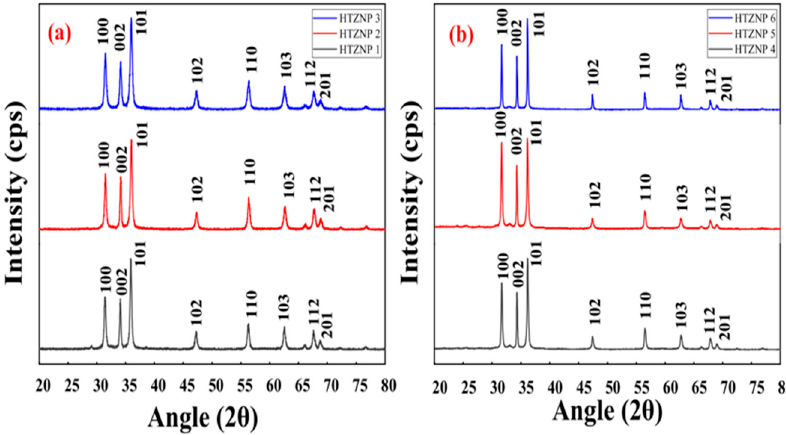
Figure 3. XRD patterns of sample synthesis with constant reaction time and different temperatures ( a ) (HTZNP1, HTZNP2, HTZNP3) and samples with constant temperature and different reaction times ( b ) (HTZNP 4, HTZNP5, HTZNP6) [28]. Reprinted from an open-access source.